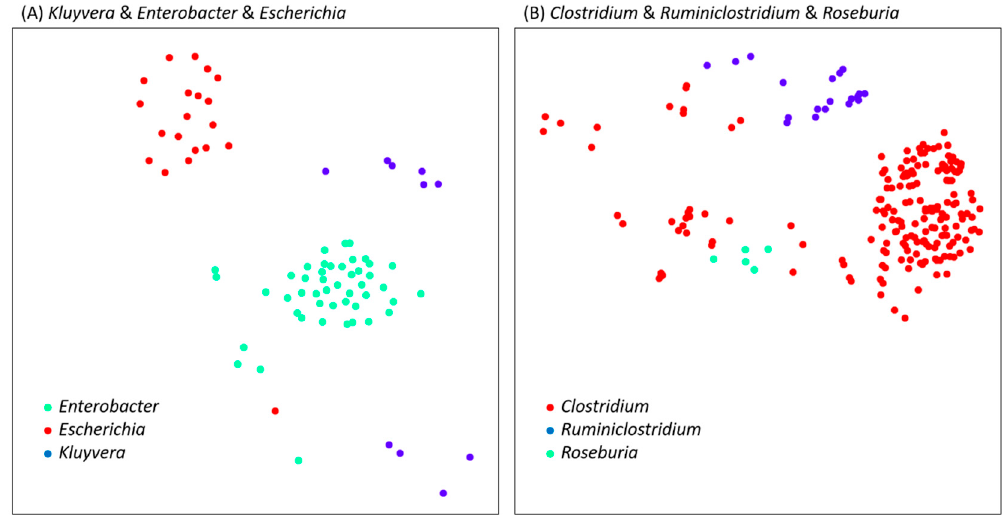
Figure 3. Multidimensional scaling ordination plot based on homologous distances among the dataset Kluyvera and Enterobacter and Escherichia ( A ) and Clostridium and Ruminiclostridium and Roseburia ( B ). Different colors represent different